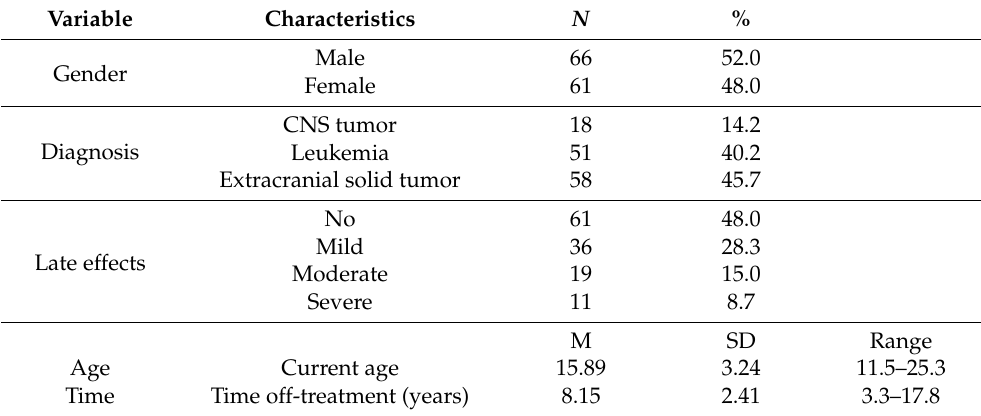
Table 1. Sample characteristics of 127 childhood cancer